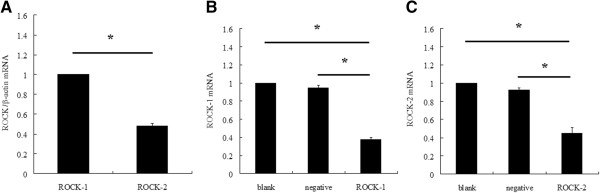
ROCK-1 and ROCK-2 mRNA expression in Y79 cell lines. (A) ROCK-1 and ROCK-2 mRNA expression in Y79 cell (*P < 0.05, n = 3). (B) ROCK-1 mRNA level in Y79 cell in blank control group, negtive control group and ROCK-1 siRNA group (*P < 0.05, n = 3). (C) ROCK-2 mRNA level in Y79 cell in blank control group, negtive control group and ROCK-2 siRNA group (*P < 0.05, n = 3).